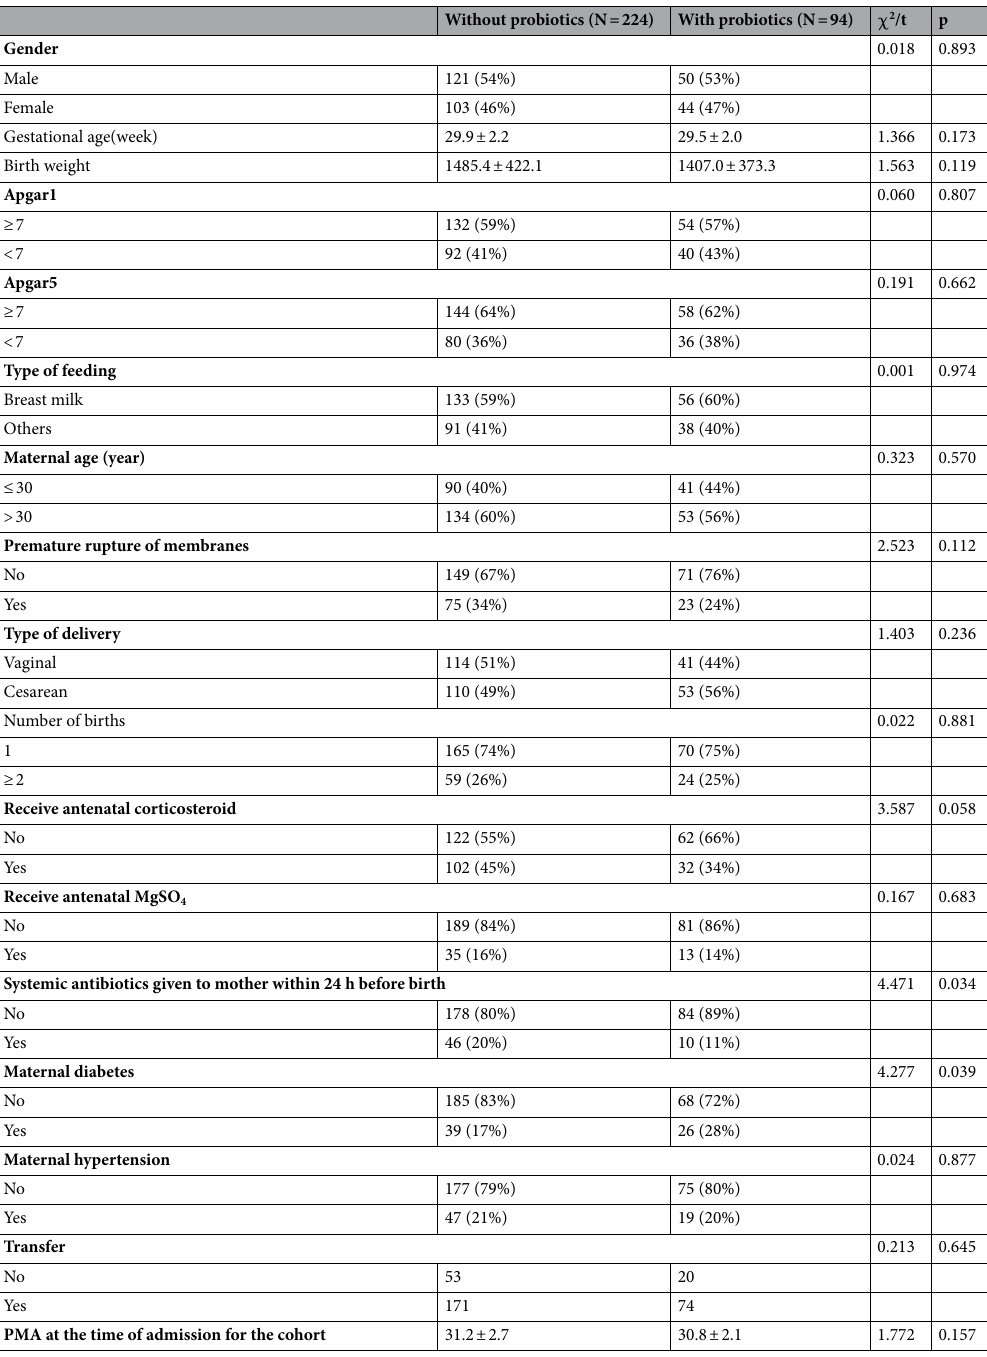
Table 1. Demographic characteristics of the study